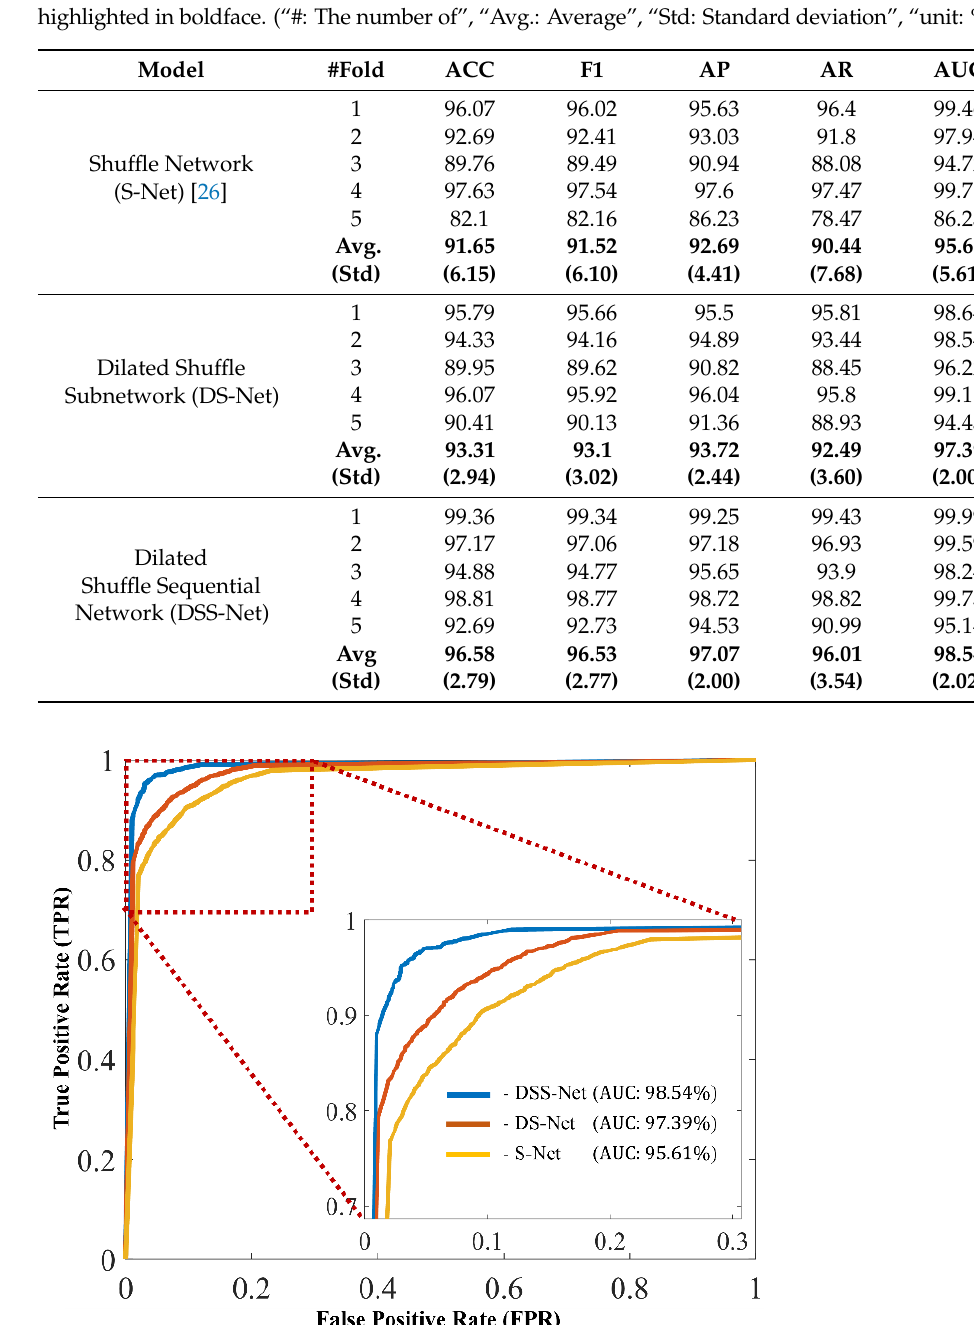
Figure 6. Performance comparison of DSS-Net, DS-Net, and S-Net in terms of confusion matrices. The initial trainable parameters of the shuffle blocks in DS-Net were acquired from a pretrained S-Net through transfer learning. Therefore, DS-Net and DSS-Net were trained from scratch to highlight the quantitative gain of transfer learning in the proposed method. The comparative results of transfer learning and training from scratch are pre- sented in Table 3. In the case of DS-Net, the results imply (Table 3) that transfer learning outperforms training from scratch with average gains of 9.87%, 10.32%, 8.9%, 11.53%, and 10.6% in terms of ACC, F1, AP, AR, and AUC, respectively. Similarly, significant perfor- mance gains of 7.97%, 7.47%, 4.63%, 9.66%, and 10.85% were observed in terms of ACC, F1, PRE, REC, and AUC, respectively, for DSS-Net. Table 3. Comparative results of the proposed DSS-Net and DS-Net with and without performing transfer learning. (“T.L: Transfer learning”) . Model